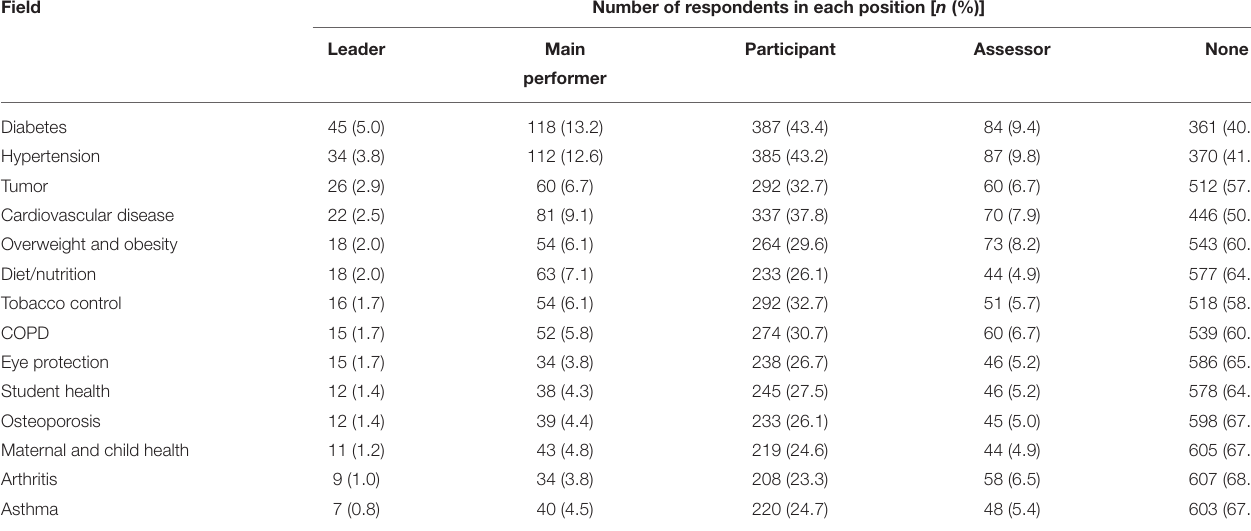
TABLE 4 | The number of evidence-based programs attended and roles in specific chronic disease fields ( n =